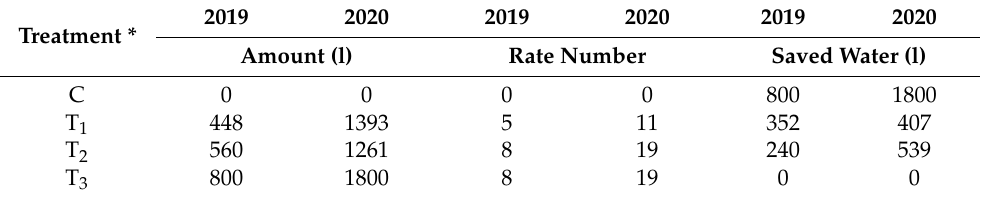
Table 1. Amount of water added per tree, number of rates and the amount of water saved as compared to T 3 over the two-year period (2019 and 2020).